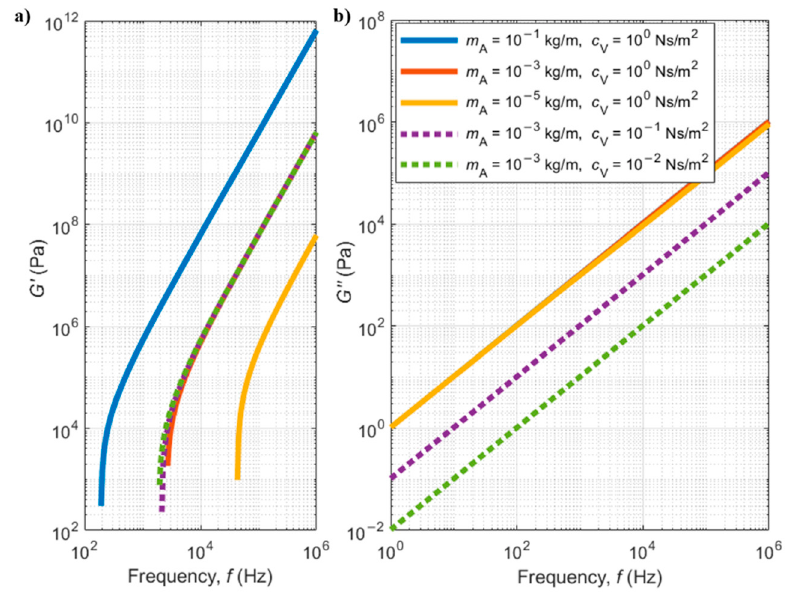
Figure 10. ( a ) Elastic and ( b ) viscous components of the dynamic modulus of a rectangular mi- crocantilever (width w = 10 µ m) as a function of the frequency of oscillation in the fluid (water, ρ f = 1000 kg/m 3 ) and of the added mass and viscous coefficient, calculated with Equations (73) and